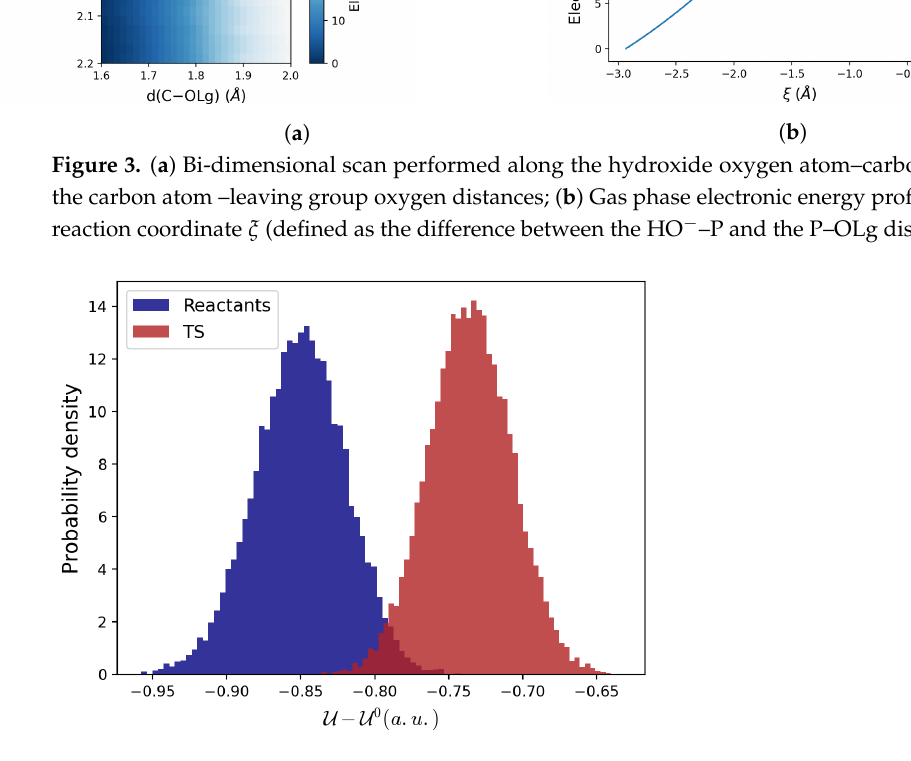
Figure 4. Reactants and TS perturbed electronic energies distributions with respect to their corre- sponding unperturbed states.